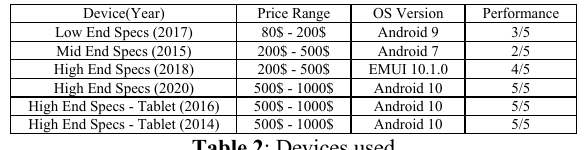
Table 2 : Devices used